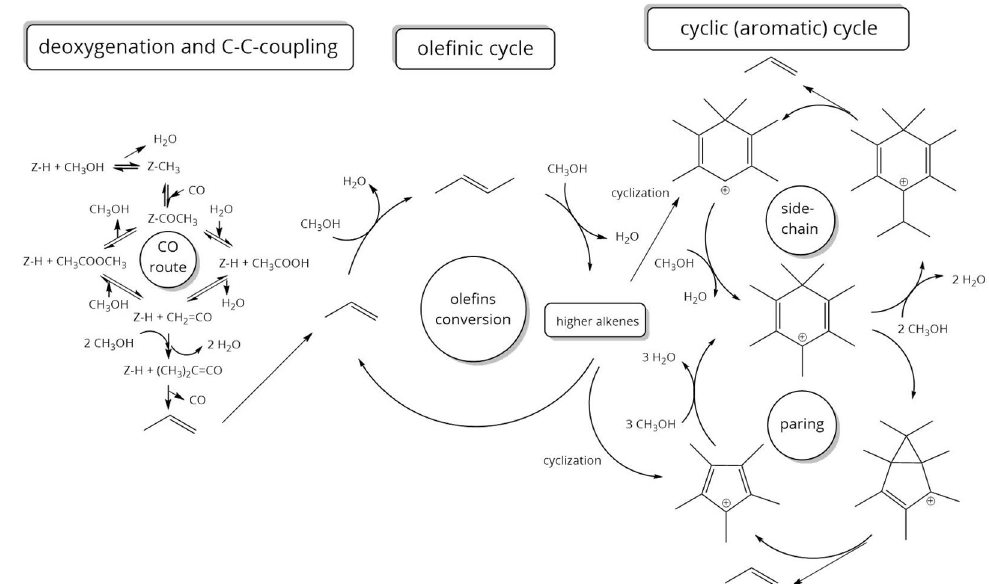
Figure 1. Schematic overview of methanol conversion and product formation on H-ZSM-5 with deoxygenation and first C-C-coupling and the following dual-cycle mechanism for hydrocarbon interconversion from olefinic and cyclic (aromatic) species [16–19].